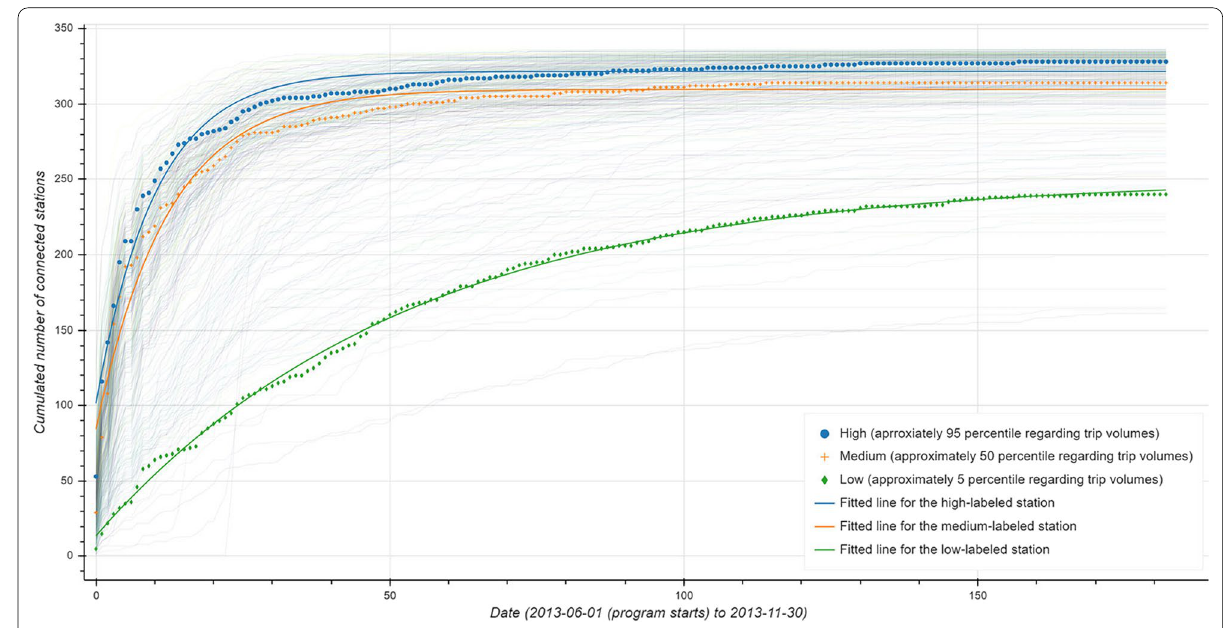
Fig. 9 Raw growth trajectories and modeled curves of three representative stations